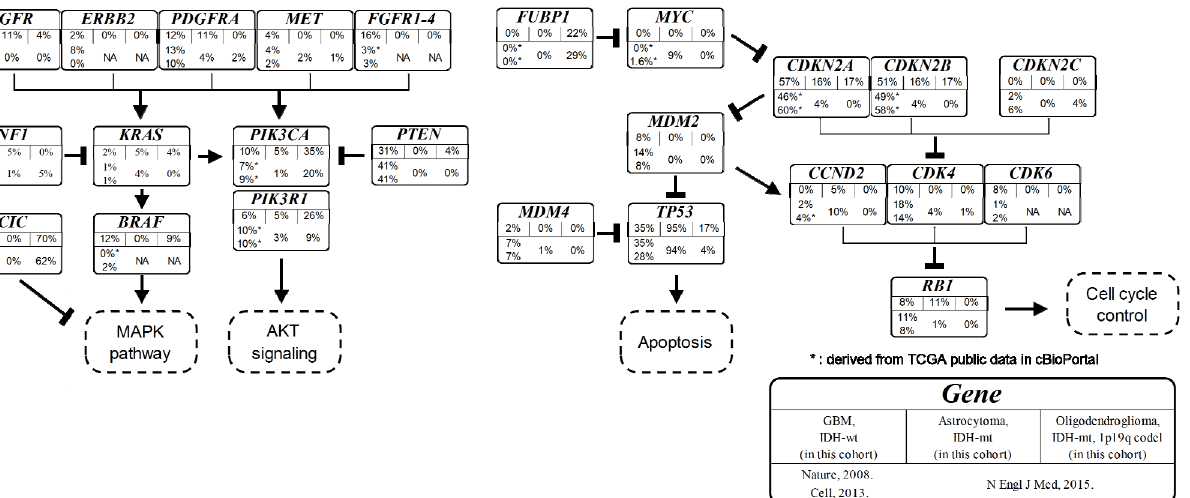
Figure 4. Results of frequently reported genes in genomic profiling test or next-generation sequencing in glioma. Frequently reported genes are categorized into representative signaling pathways, and their frequency is illustrated in each box entitled to the gene. In each box, (I) the top row indicates the name of the gene; (II) the middle row indicates the frequency of genomic aberrations in our cohort for the selected histological classification groups, such as IDH -wt glioblastoma, IDH -mt astrocytoma, and oligodendroglioma IDH -mt 1p19q co-deleted; (III) the bottom row indicates the reference study. (*): missing data in the original reference, and the corresponding frequency is derived manually from cBioPortal (https://www.cbioportal.org/, accessed on 1 February 2022). Nature , 2008 (reference [20]): Cell , 2013 (reference [21]), N. Engl. J. Med. , 2015 (reference The patients’ access to therapeutic agents is an important factor to be considered. All